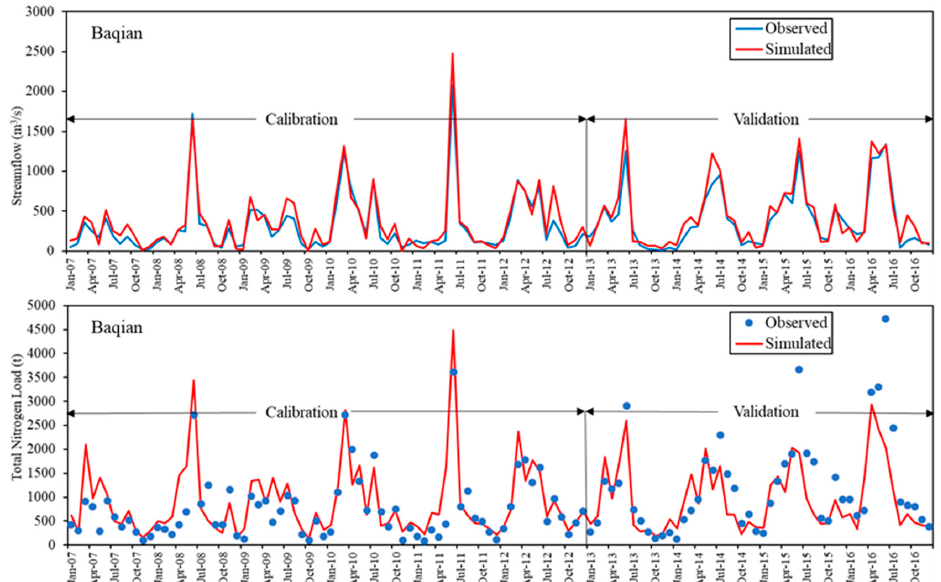
Figure 2. Observed and simulated daily streamflow values and monthly TN loads at the basin’s outlet at Baqian.